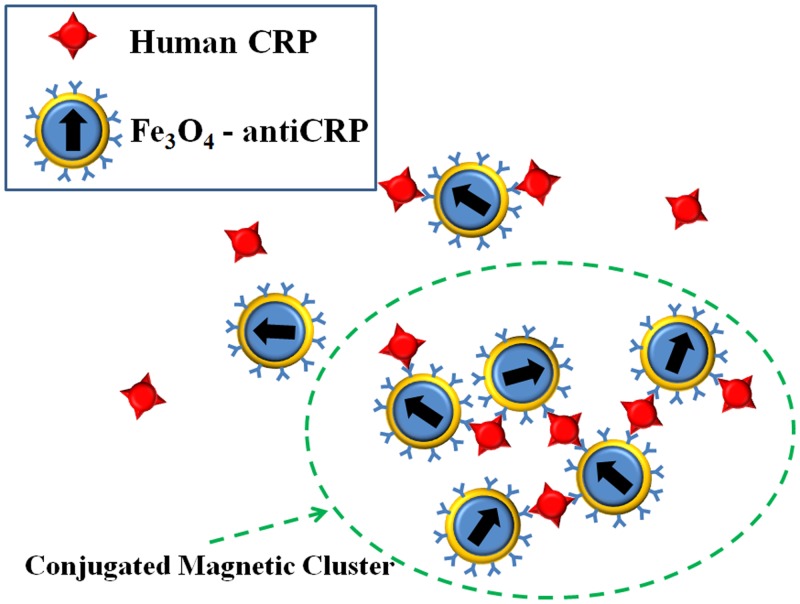
Illustration depicting conjugation of human CRP and Fe3O4-antiCRP to form Fe3O4-antiCRP-CRP cluster.